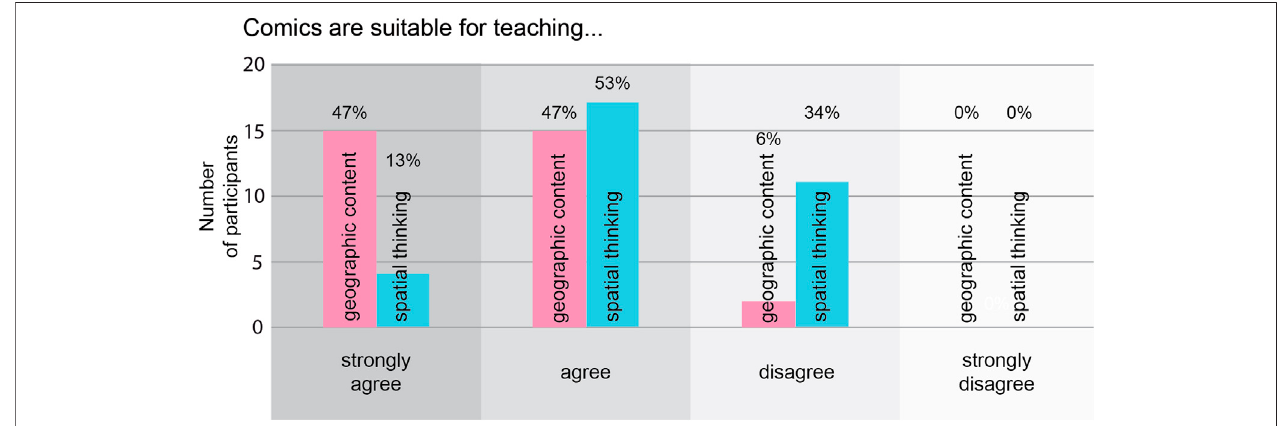
FIGURE 2 | Attitudes of Geography teacher trainees towards teaching Geography with comics on a Likert scale ( n (cid:1) 32).